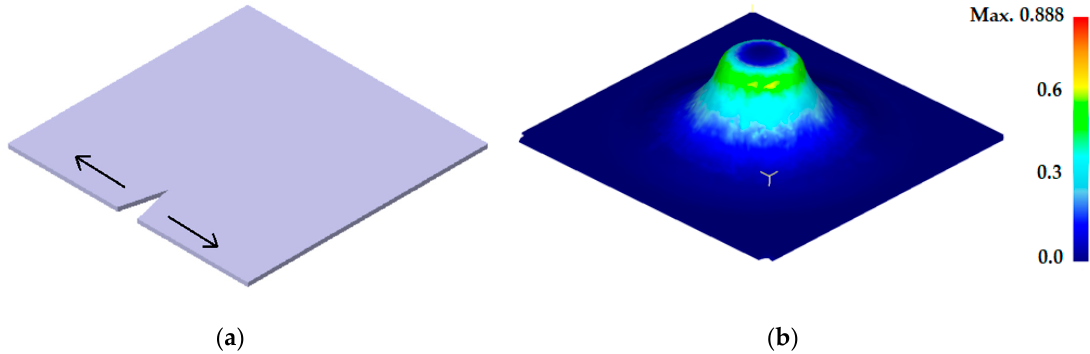
Figure 12. ( a ) Crack produced under In-plane tension corresponding to the Mode I and ( b ) Contour of accumulated damage using McClintock damage criterion for Ф 10 mm and step down 0.5 mm/pass.